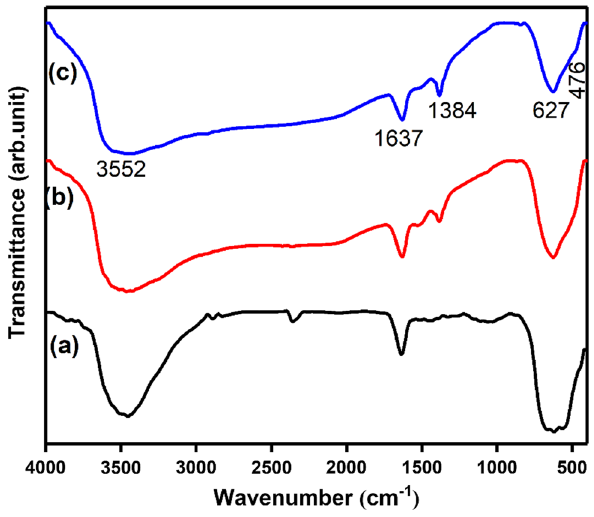
Fig. 2 FTIR spectra of (a) SnO 4% Y-doped SnO 2